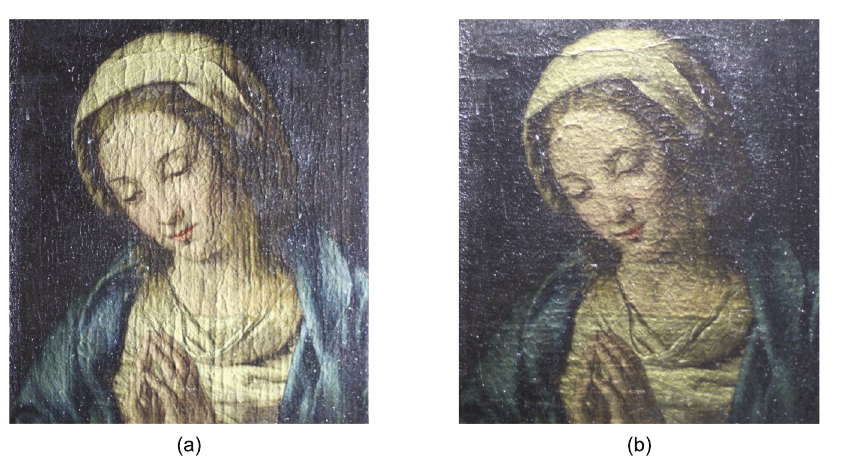
Figure 10. White-light raking images of Madonna in Preghiera with the light source ( a ) placed on the right side and ( b ) the top side of the